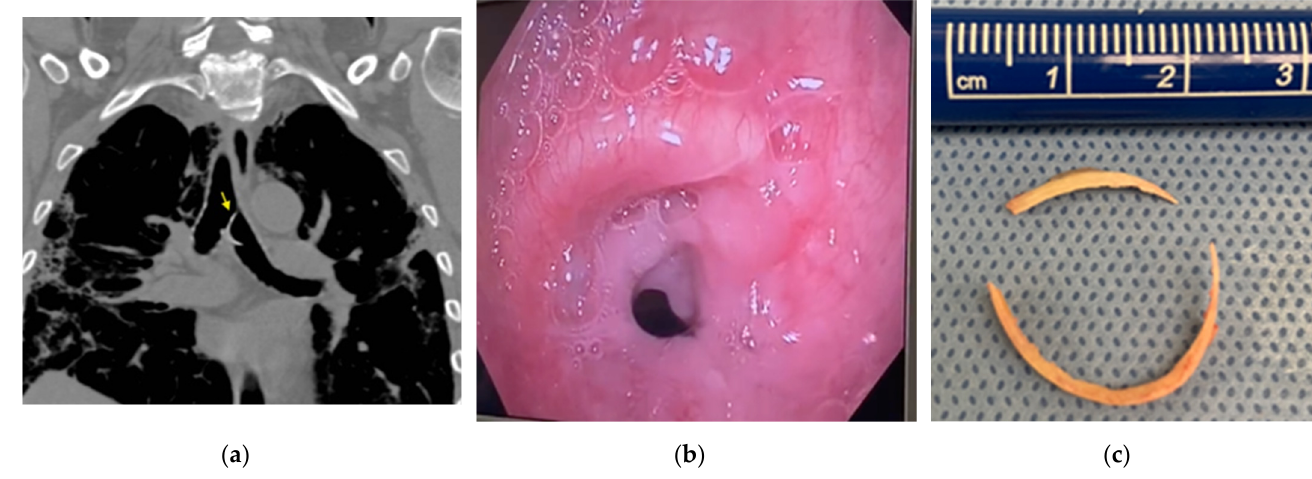
Figure 1. ( a ) SGS occurring at the cricoid cartilage, which was fractured and is protruding into the airway lumen (yellow arrow); ( b ) non-contrast chest CT scan, coronal view showing a curvilinear hyperdense foreign body in the proximal left mainstem bronchus marked with arrow; ( c ) gross appearance of foreign body.